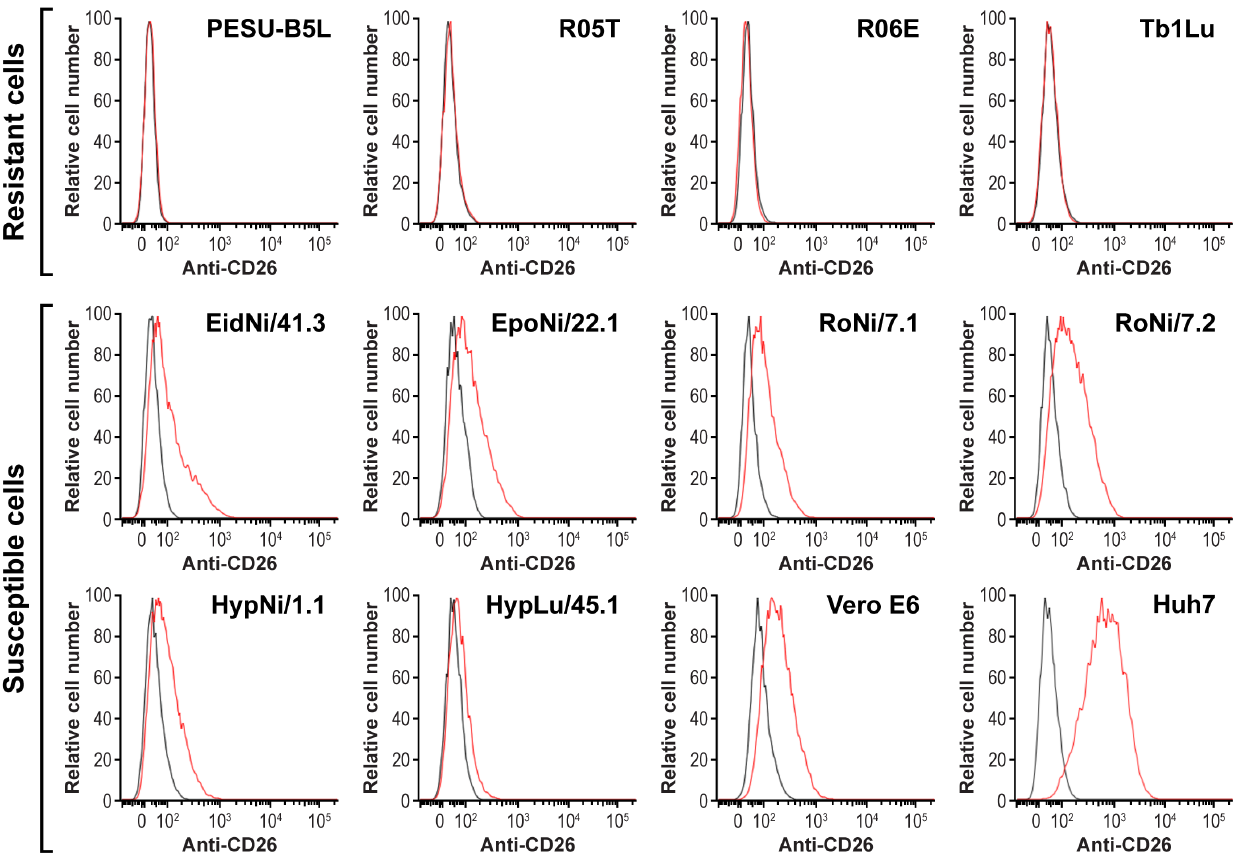
Figure 2. Cell-surface expression of CD26/DPP4 on bat cells. Cells of different bat cell lines were analyzed by flow cytometry after staining with goat anti-human DPP4/CD26 antibody (red line) or control antibody (black